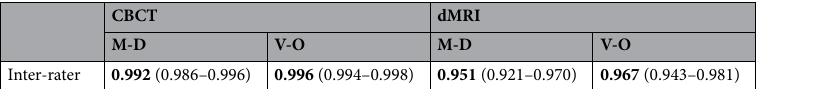
CBCT dMRI M-D V-O M-D